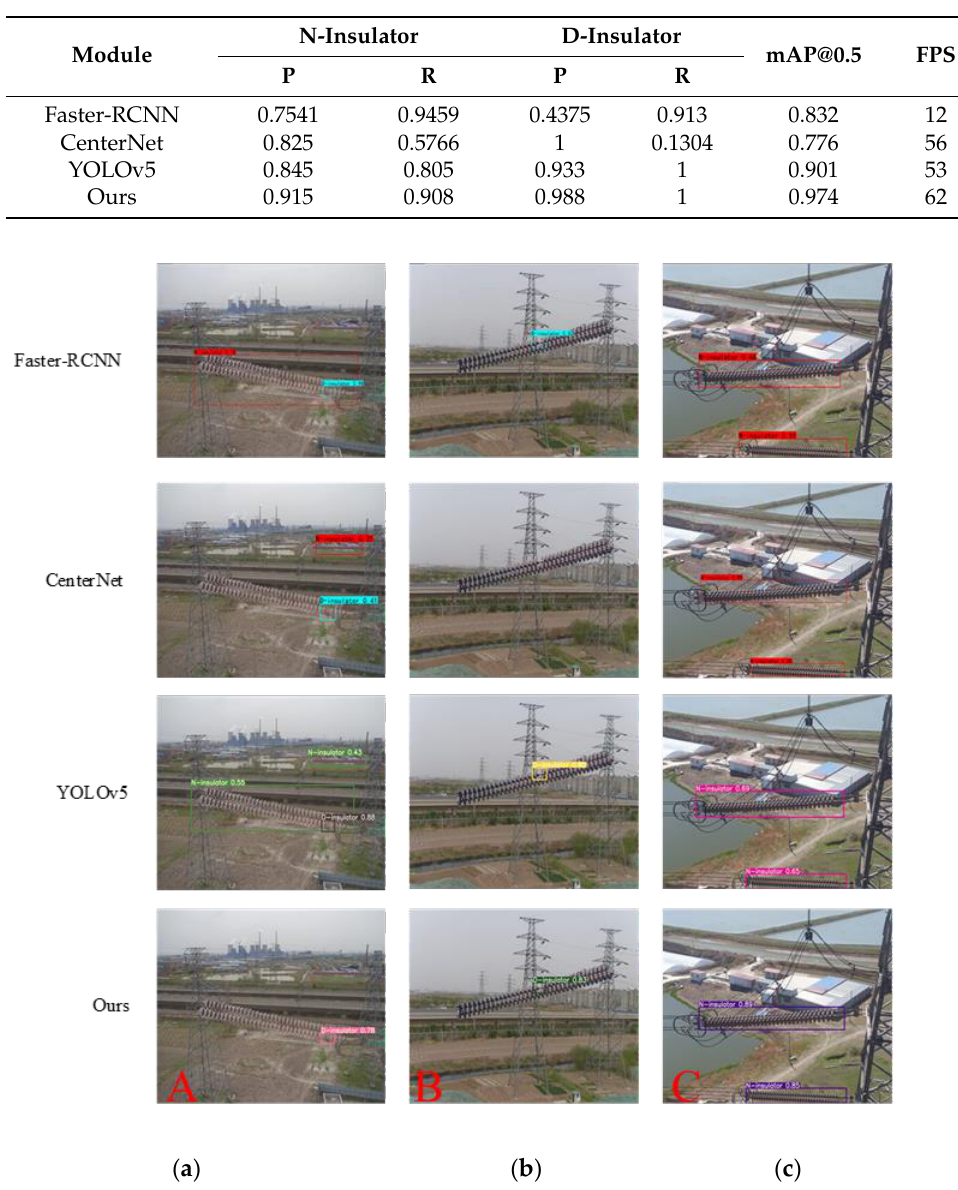
Figure 7. Detection results of different network models. ( a ) Figure A shows the detection results under different network models; ( b ) Figure B shows the detection results under different network models; ( c ) Figure C shows the detection results under different network